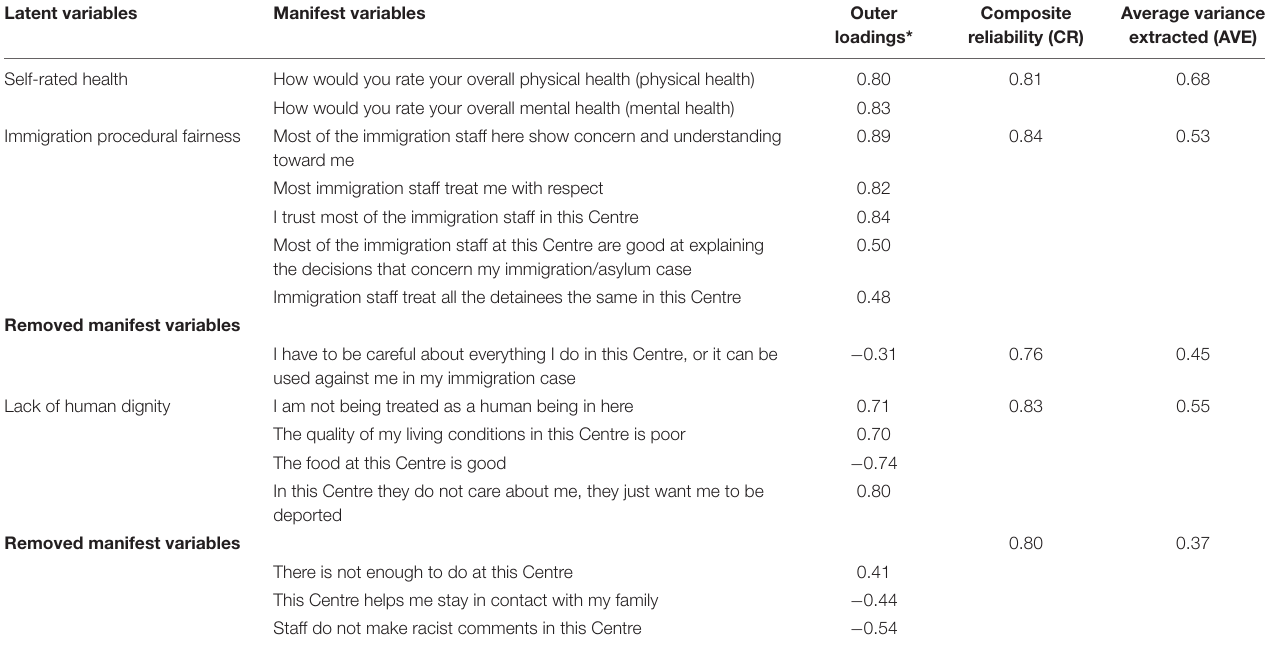
TABLE 2 | Reliability and convergent validity indexes for Self-rated health, Immigration procedural fairness, and Lack of human